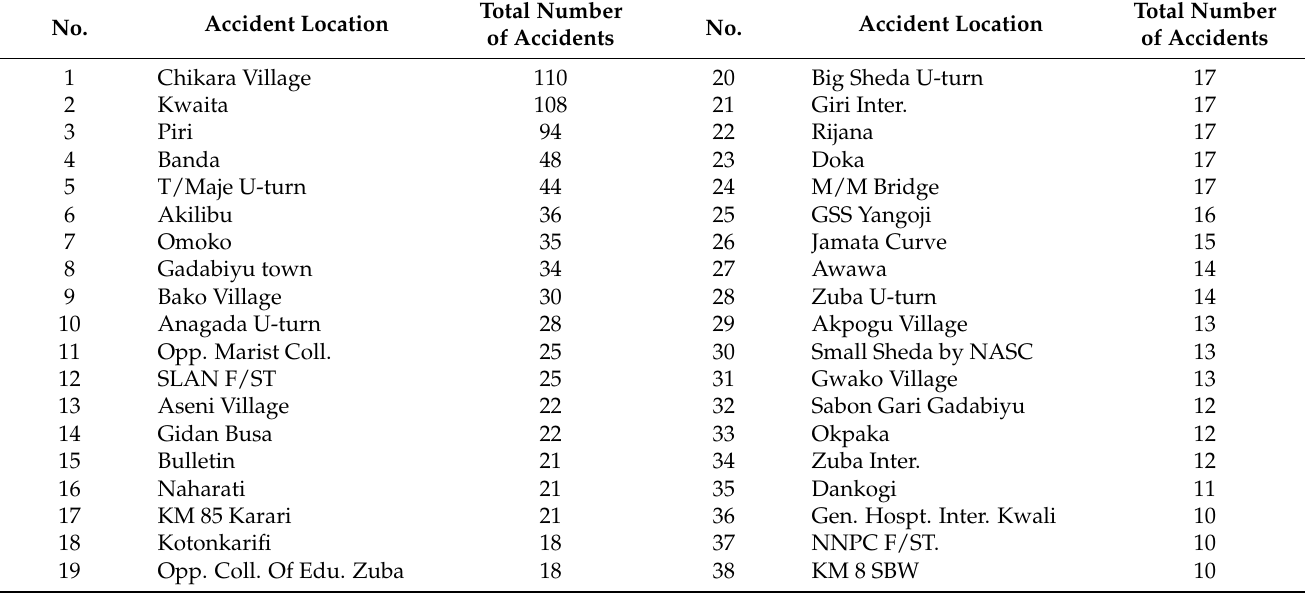
Table 4. Southbound locations with number of accidents of 10 or more